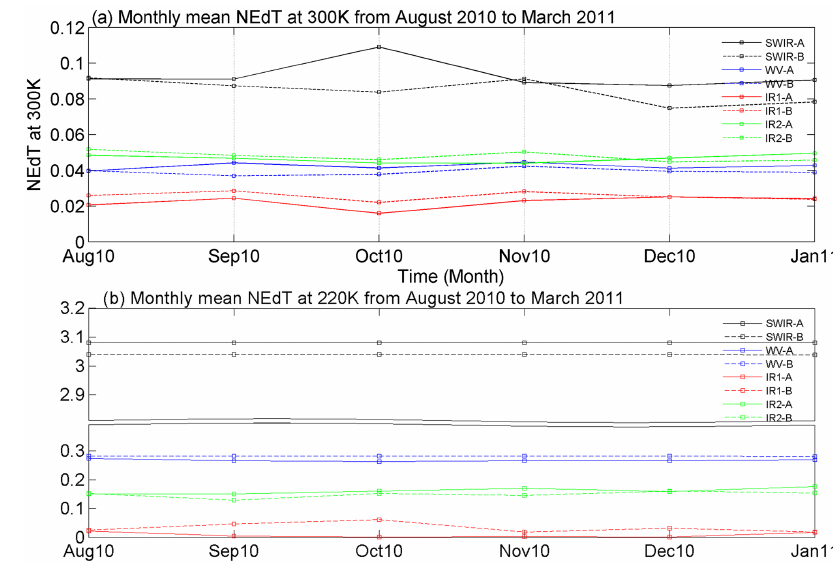
Figure 7. Monthly mean NEdT at 300K (a) and 220K (b) for four IR channels from August 2010 to January